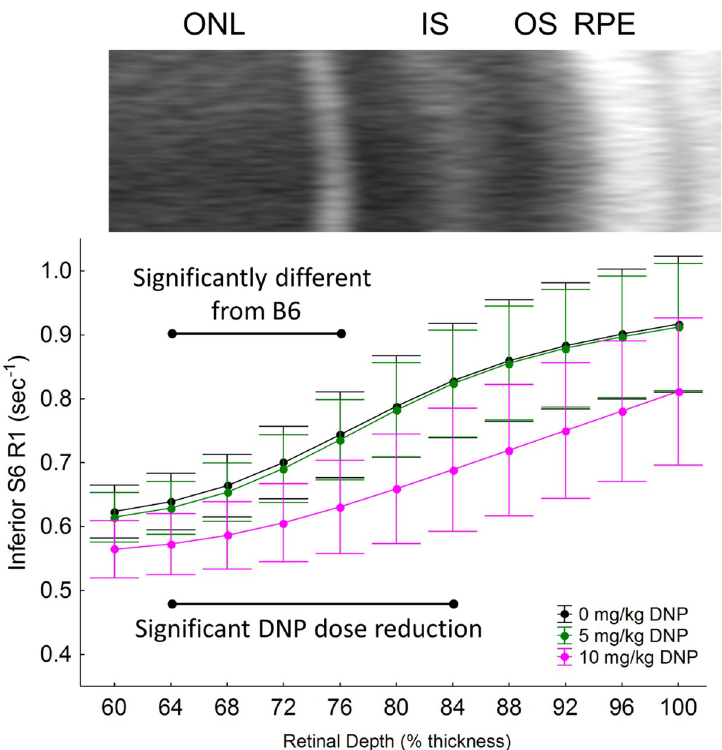
Fig 4. To highlight the localized differences in inferior retina of S6 mice, modeling results are replotted on an expanded scale for 1/T1 MRI profiles in vivo ~1 hr post DNP in inferior retina of dark-adapted mice after injection of either saline (0 mg/kg, black, n = 7), 5 mg/kg DNP (green, n = 8), or 10 mg/kg DNP (pink, n = 10). An expanded region of the representative OCT image from inferior retina of S6 mice is also shown above the profiles. Other conventions are as in Fig 4 and its legend. Black range bar: Retinal depth range with significant differences (p < 0.05) as indicated. Error bars represent 95% confidence intervals.